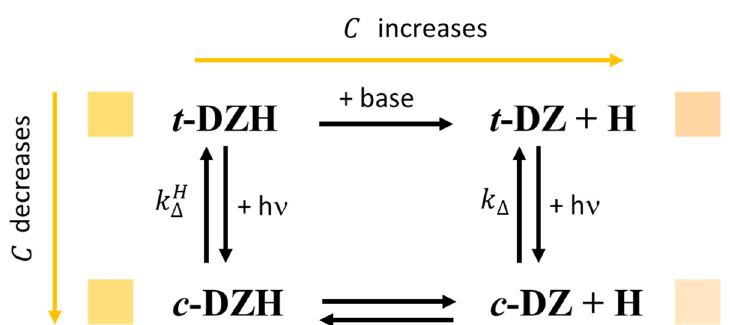
Figure 9. Schematic representation of the photochromic properties of t -DZH and its conjugated base, t -DZ . The colours shown next to each molecule refer to those determined in the aqueous micellar solution of SB3-14 with [ t -DZH ] ≈ 4 × 10 − 5 M .